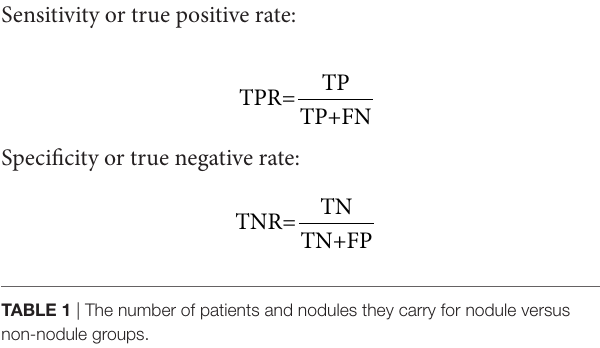
FigUre 4 | Training and validation loss is shown on the training data for 120 epochs. Blue line corresponds to training loss and orange line corresponds to validation